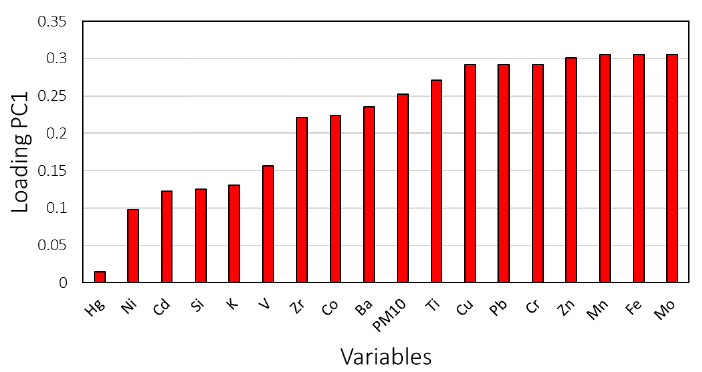
Figure 5. Loading values for PC1. The original data are expressed as metals mass amounts per unit of volume of air (ng m − 3